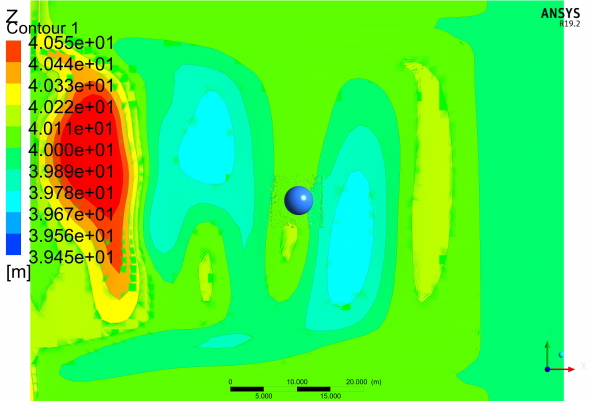
Figure 13. Wave pattern on the free surface at t = 1.5 s.